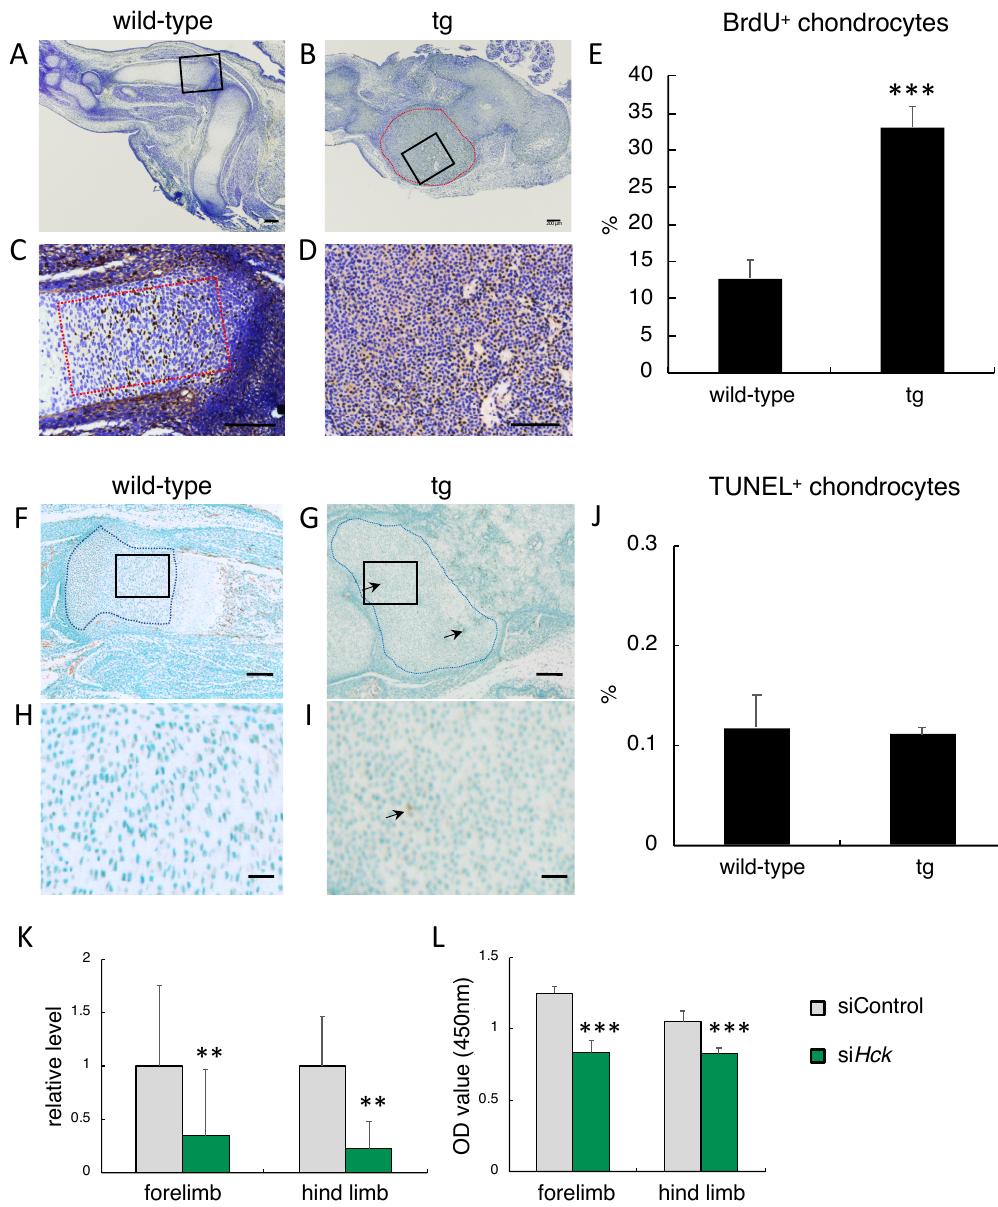
00.511.52 Figure 5. BrdU and TUNEL staining in Hck CA tg embryos and knock-down experiments in vitro. ( A – D ) BrdU staining in wild-type ( A , C ) and Hck CA tg ( B , D ) embryos at E14.5. The black boxed regions in A and B are magnified in C and D , respectively. ( E ) The frequencies of BrdU-positive cells. The BrdU-positive cells and total number of chondrocytes in the surrounded regions by red dotted lines in B and C were counted, and the frequencies of BrdU-positive cells are shown. ( F – I ) TUNEL staining in wild-type ( F , H ) and Hck CA tg ( G , I ) embryos at E16.5. The boxed regions in F and G were magnified in H and I , respectively. The arrows in G and I indicate TUNEL-positive cells. ( J ) The frequencies of TUNEL-positive cells. The TUNEL-positive cells and total number of chondrocytes in the surrounded regions by blue dotted lines in F and G were counted, and the frequencies of TUNEL-positive cells are shown. Three mice were analyzed, and the means ± SD are shown in E and J . *** p <